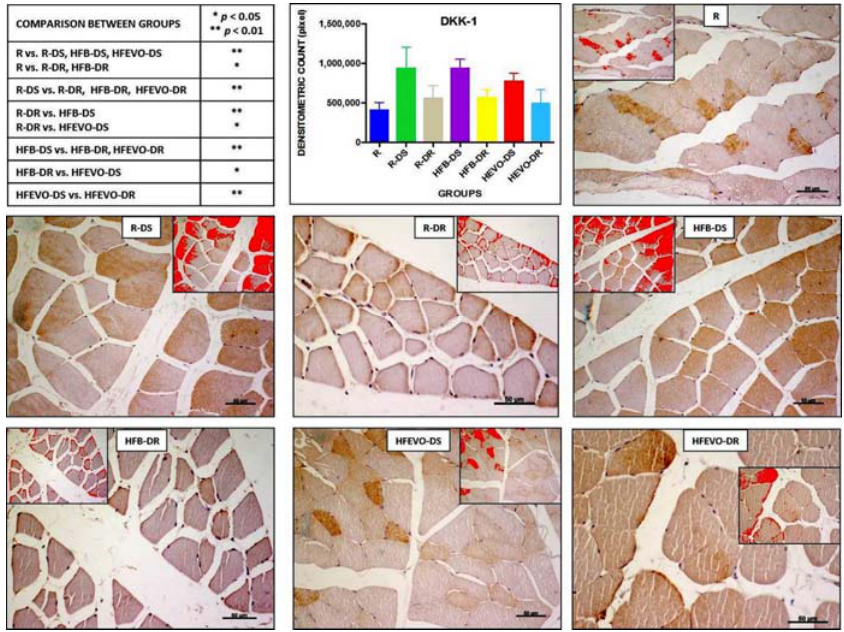
Figure 5. DKK ‐ 1 immunostaining, image analysis by software in which the red color represents the immunolabelling (inserts), and a graph representing the intensity of immunostaining (densitometric count pixel2) with statistical analysis ( p ‐ values in the table). For details, see the text. The data are presented as mean ± SD. Scale bars: 50 μ m.